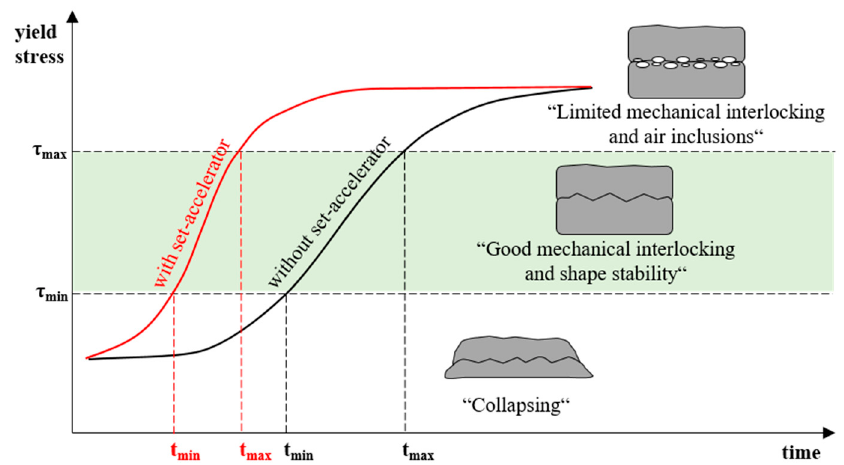
Figure 1. Principle of yield stress development over time with and without set-accelerator as well as the open window for processing shotcrete indicated by t min and t max.